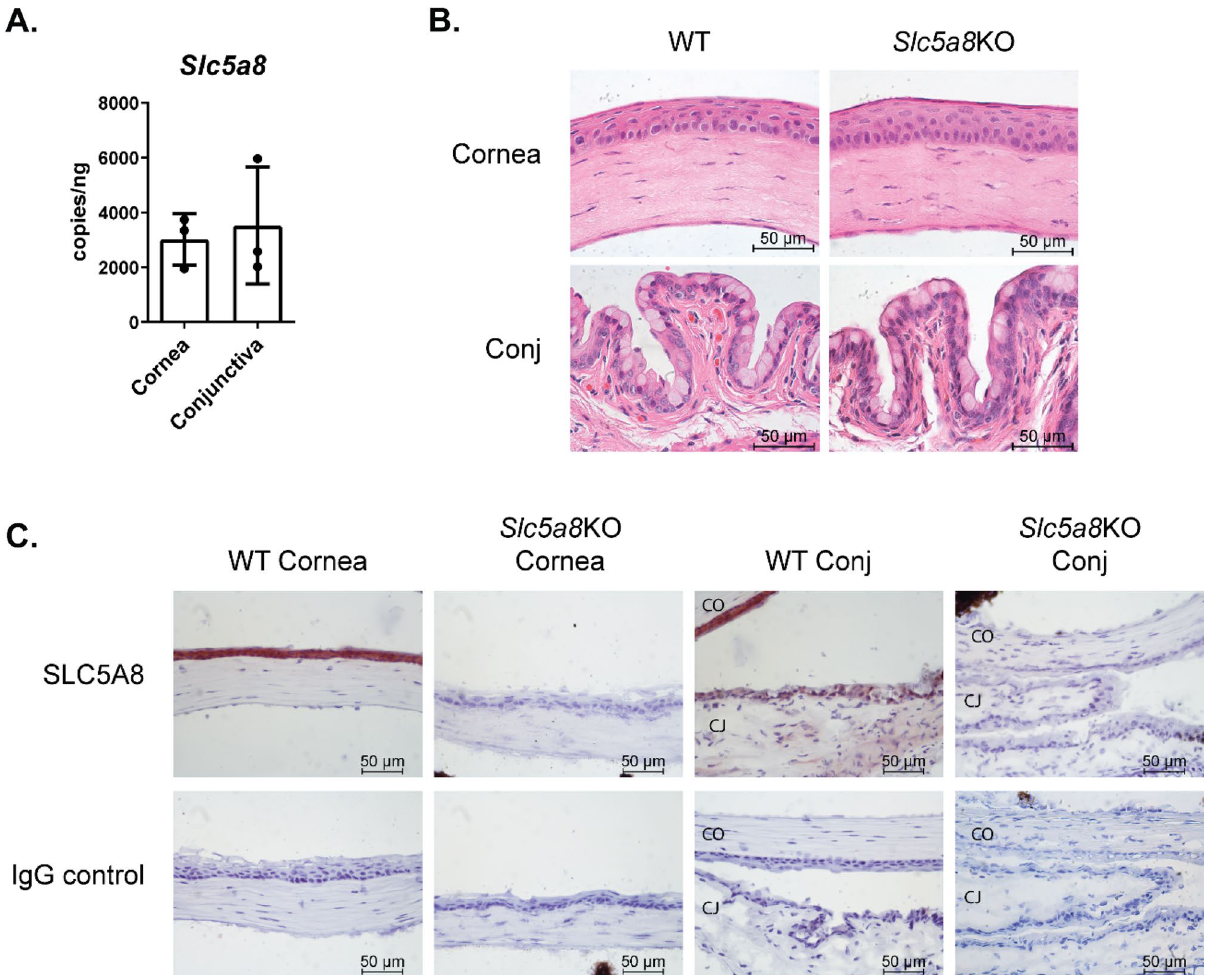
Figure 1. C57BL/6 J mice express mRNA and protein for the SCFA transporter SLC5A8 on the ocular surface. ( A ) Quantitative digital PCR was used for amplification of cDNA prepared from wild-type C57BL/6 murine corneal epithelium and conjunctival tissue. Each datapoint represents tissue from one animal. The number of transcripts detected was normalized to the concentration of DNA. ( B ) Cornea and conjunctival (Conj) sections from wild-type (WT) C57BL/6 and Slc5a8 knockout (KO) mice were stained with H&E to assess morphology. Representative images are shown. ( C ) Cornea and conjunctival (Conj) sections from wild-type (WT) C57BL/6 and Slc5a8 knockout mice were immunostained with anti-mouse SLC5A8 antibody using chromogenic detection (reddish-brown). Nuclei were stained with hematoxylin (purple). Slides stained with anti-rabbit IgG are shown as a negative control. Representative images are shown. CO = cornea; CJ =